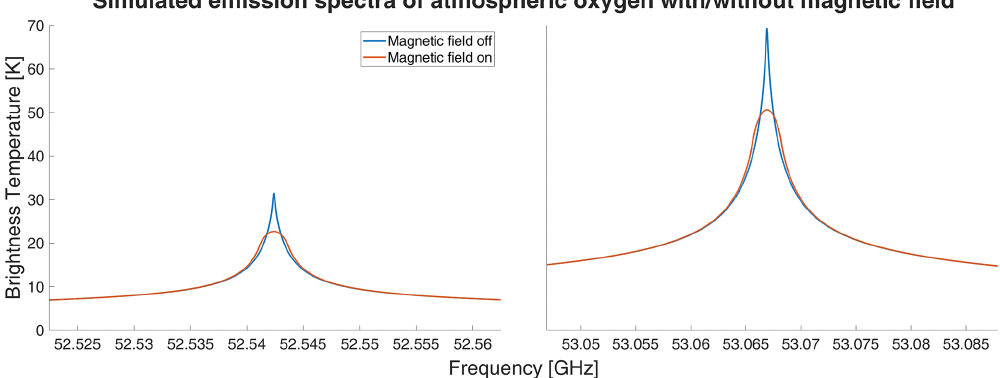
Figure 1. Illustration of the Zeeman effect on the line shape for mid-latitude observations on Earth. The line of sight is directed northwards with a zenith angle of 30 ◦ . The tropospheric effect on the brightness temperature has been